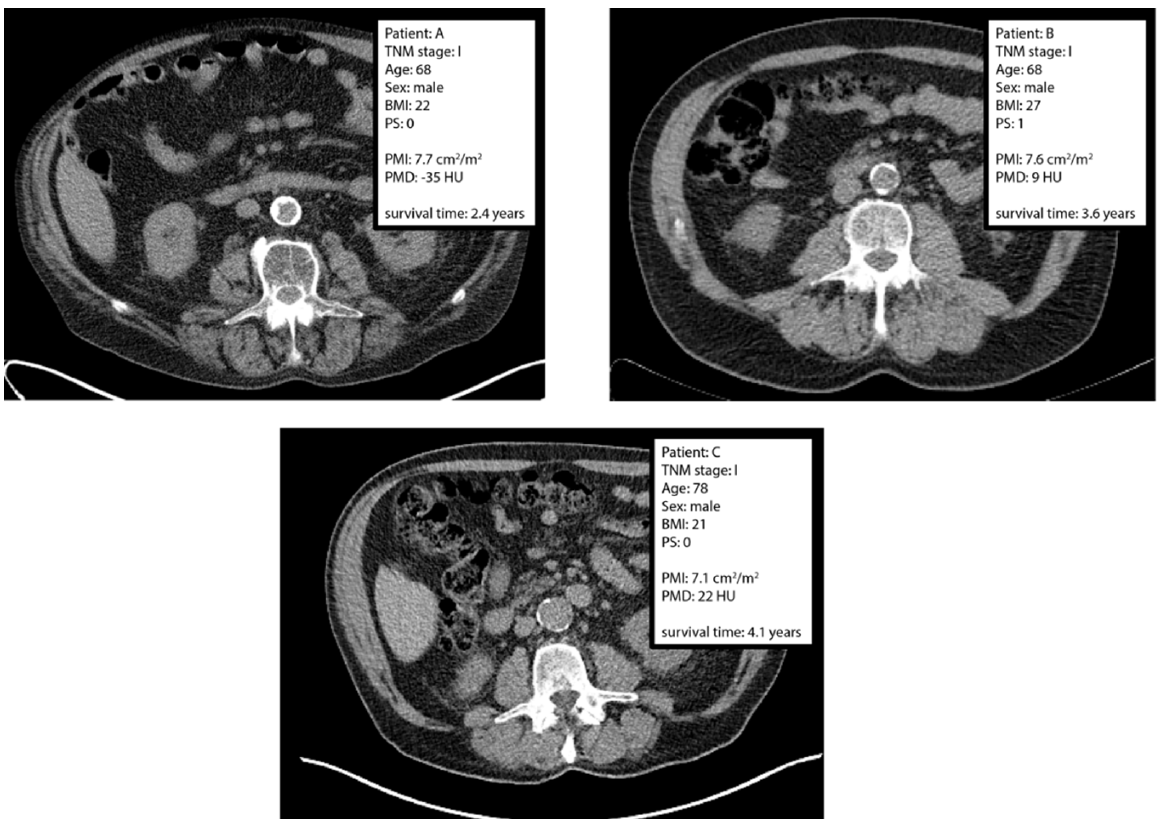
Figure 2. L3-slices of computed tomography scans for three different patients with similar psoas muscle index (PMI) but different psoas muscle radiodensity (PMD). The patients were selected to be similar with respect to stage, age, sex and PMI, but with different PMD. BMI: body mass index. PS: performance score, defined using the Eastern Collaborative Oncology Group standard [23].